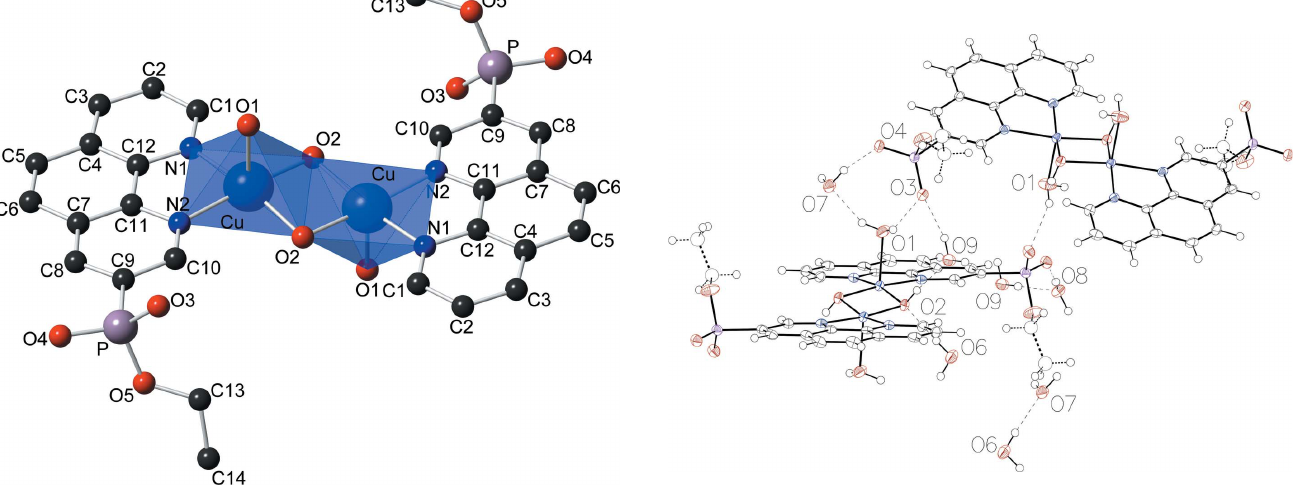
Figure 3 ORTEP view of the hydrogen-bonding interactions (dashed lines; see Table 1) in the title compound. Displacement ellipsoids are drawn at the 50% probability level.